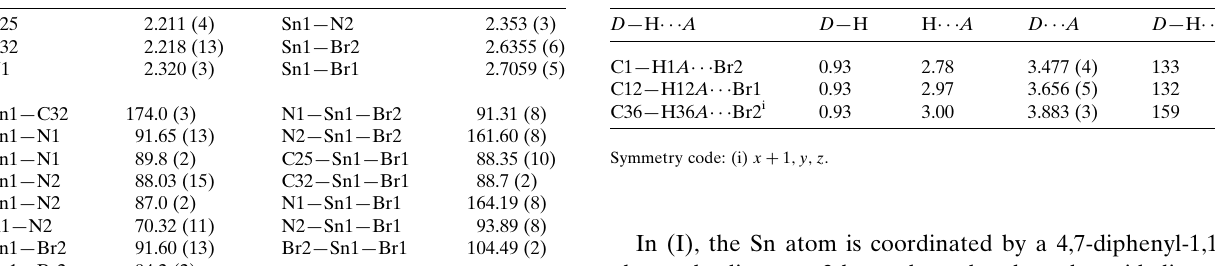
Table 2 Hydrogen-bond geometry (A˚ , (cid:4) ).